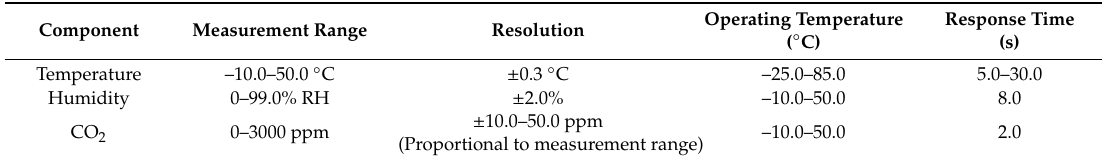
Table 1. Sensor specifications for the inside climate of the greenhouse.